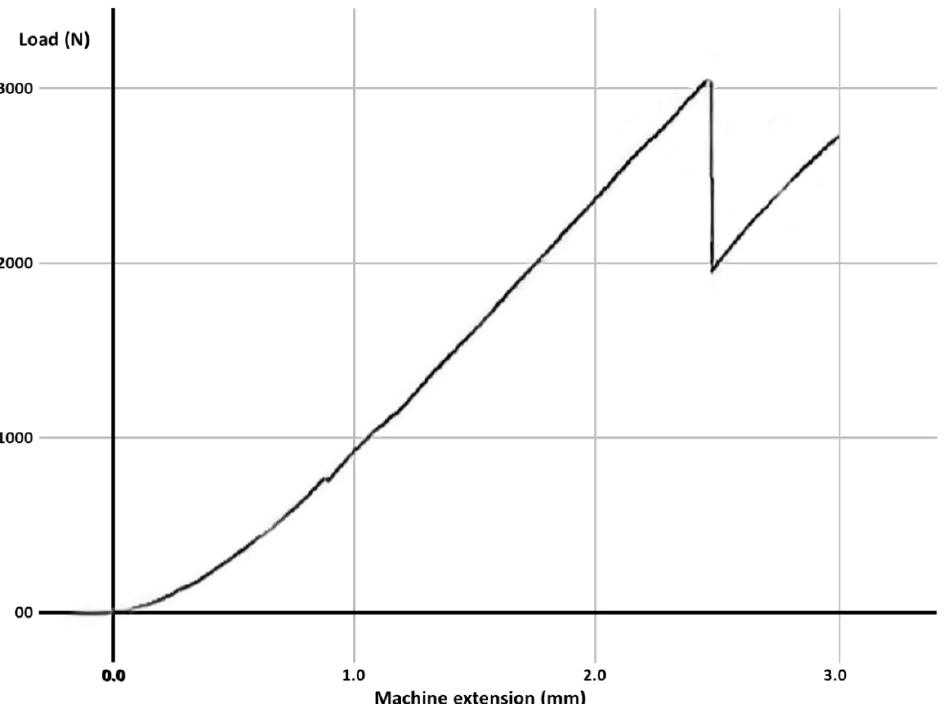
Figure 3. The maximum value of the force at which the most resistant molar from Group B failed.